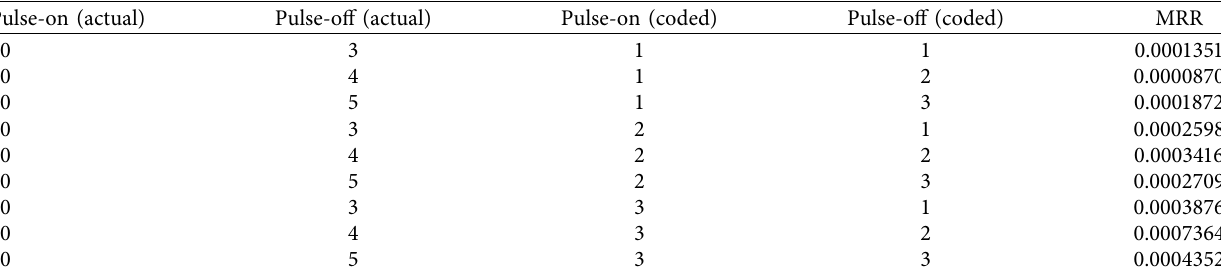
Table 6: MRR values for aluminium.